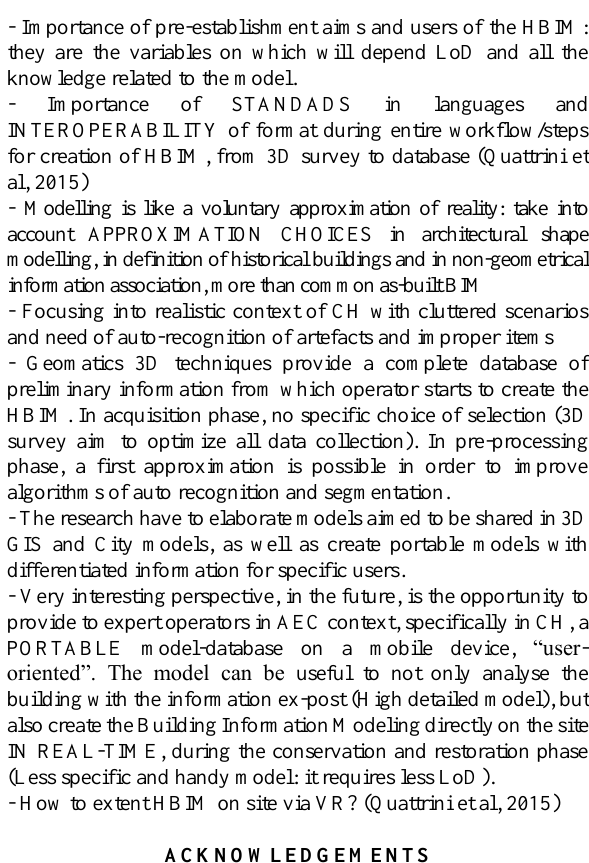
Figure 18. Creation of a tileable texture: right, casual reiteration of a digital image; left, casual reiteration of a tileable image